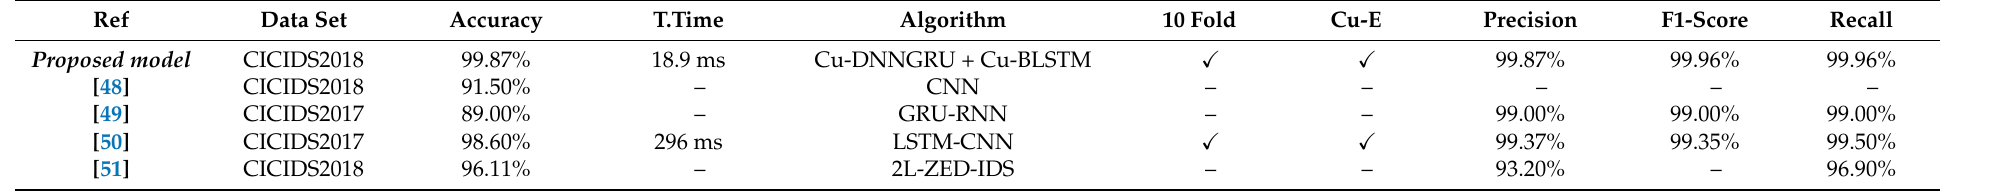
Table 6. Comparison of proposed model with existing